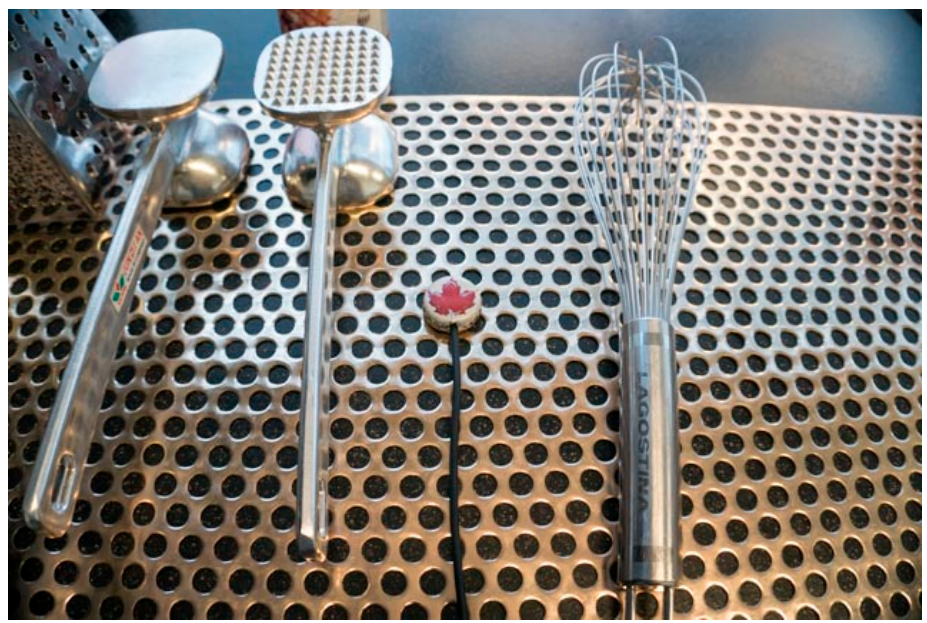
Figure 4. A contact microphone placed on the motherboard surrounded by kitchen tools. Testing Grounds, Southbank Arts Centre, Melbourne, Australia. From the sound performance work, Being in Time: Death by Audio , 2018.